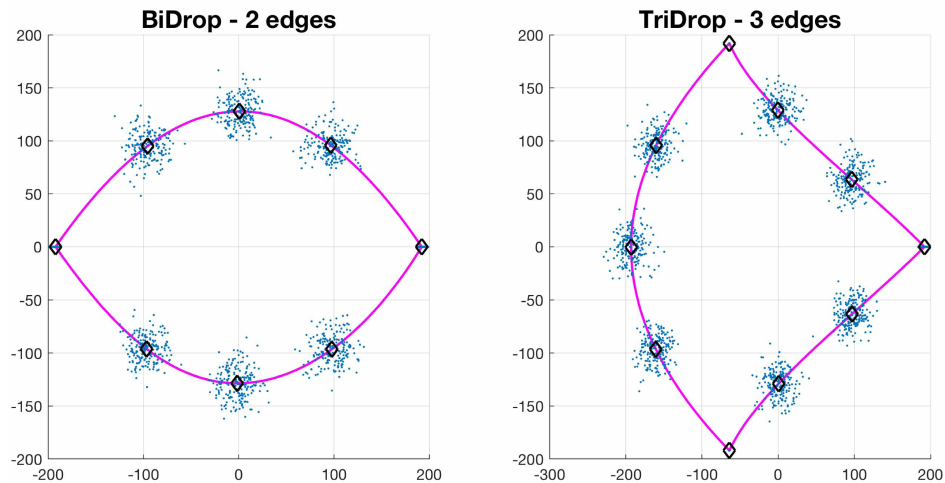
Figure 4. Synthetic generation of random basic shapes. Per shape, 200 cases were generated. The control points are shown in blue ( points are represented in black (